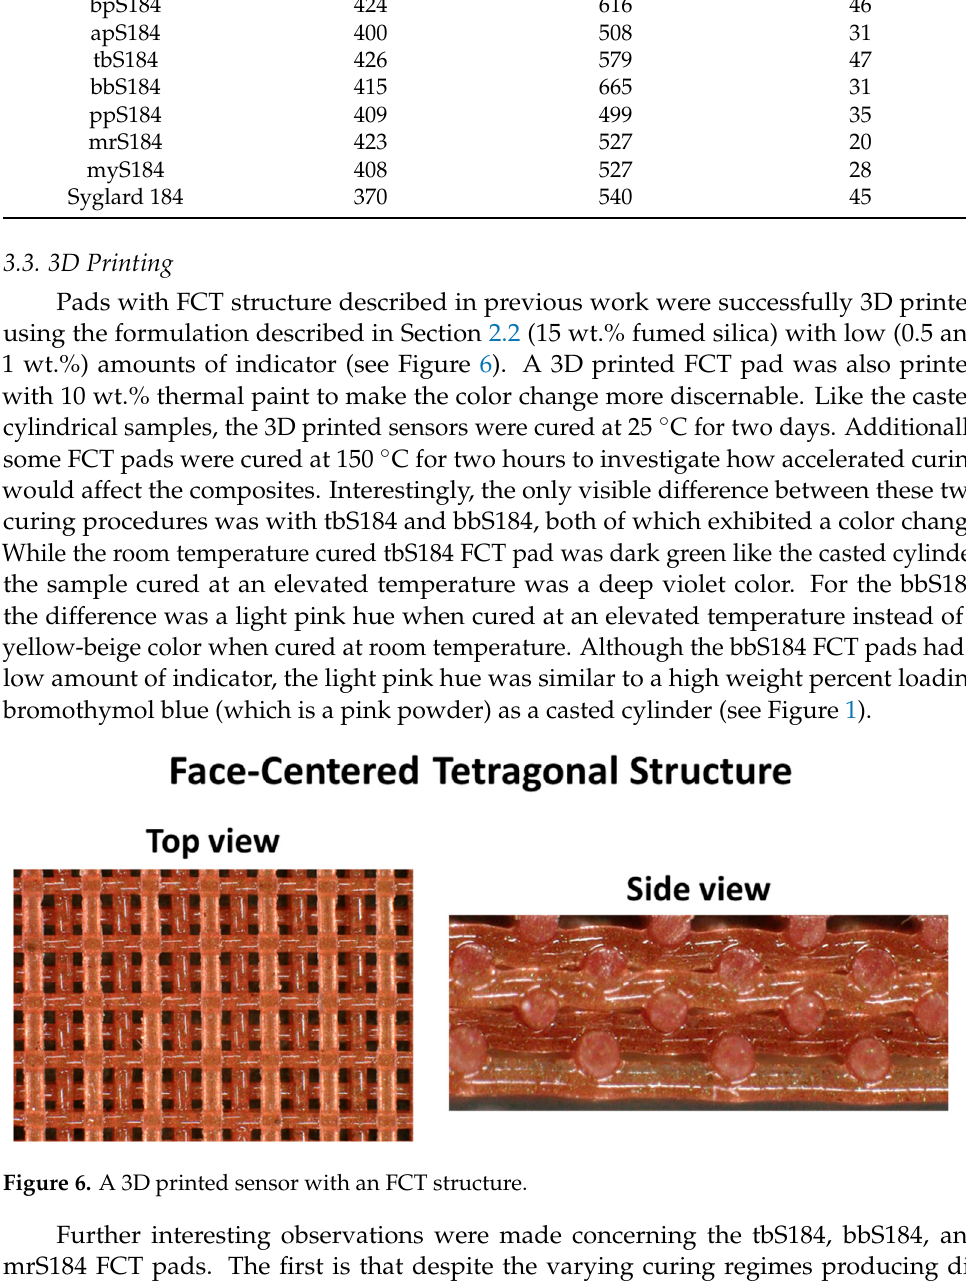
Table 4. Thermal properties of the 0.5 wt.% composite chromophoric sensors compared to Sylgard